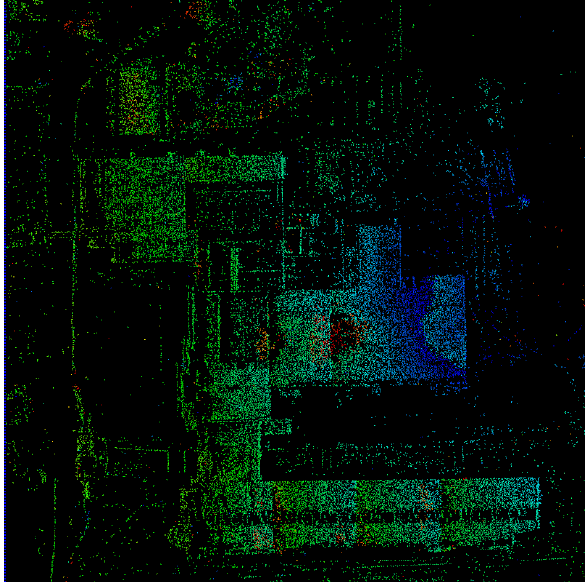
Figure 7. Zoom in onto the Las Vegas Convention